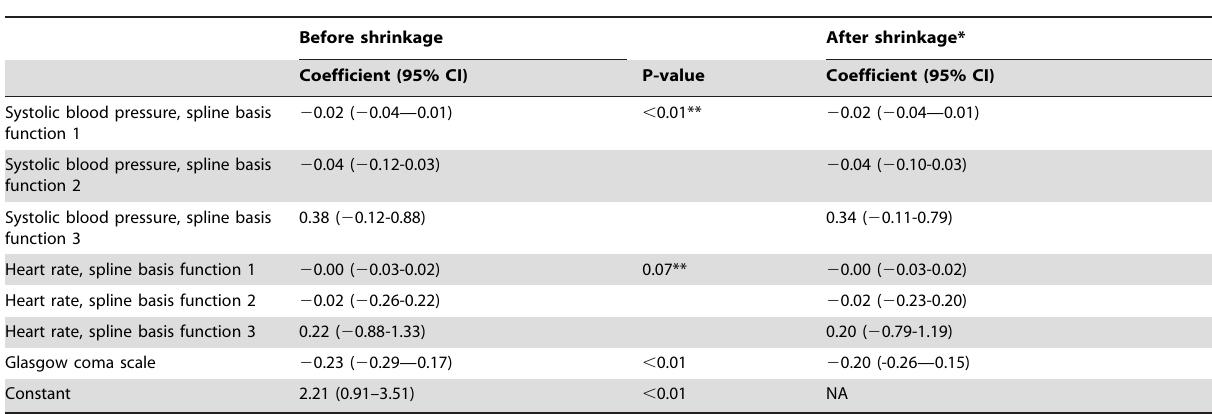
Table 2. Final model